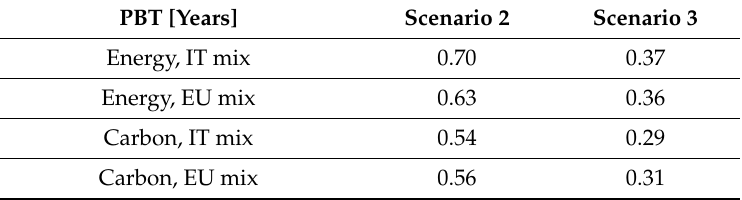
Table 12. PBT (Payback times) and sensitivity analysis on IT and EU energy